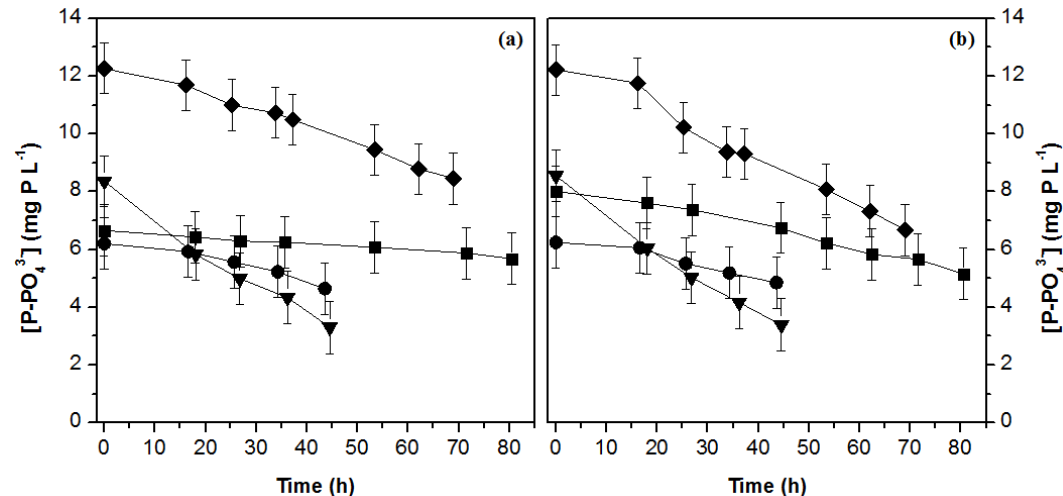
Figure 6. Temporal variation of phosphorus concentration (P-PO 43 − ) in PBR 1 ( a ) and PBR 2 ( b ) for all assays: I— (cid:4) ; II – • ; III— (cid:72) ; IV— (cid:7) . Error bars correspond to the standard deviation of the mean determined for duplicates from two independent experiments.